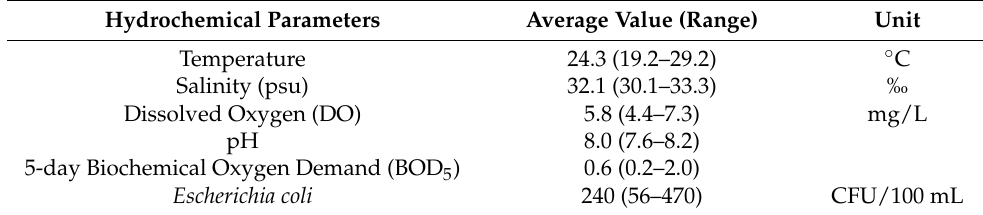
Figure 1. A geographical map showing the seawater sampling site along the coastline and its location. Table 1. Some basic physicochemical properties of seawater sample.